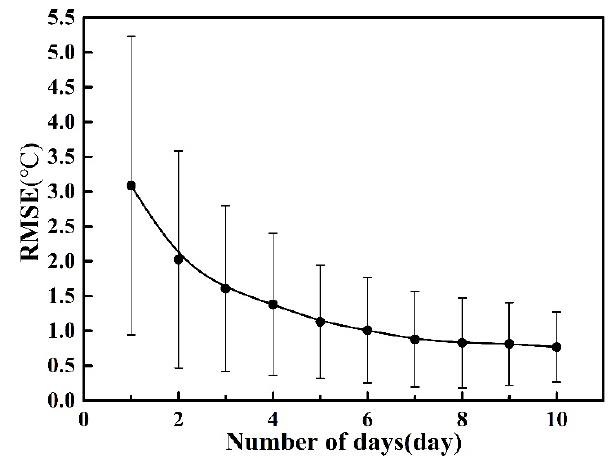
Figure 3. Variations in RMSE (Root Mean Square Error) with the number of valid days and its error bar (±1 standard deviation).